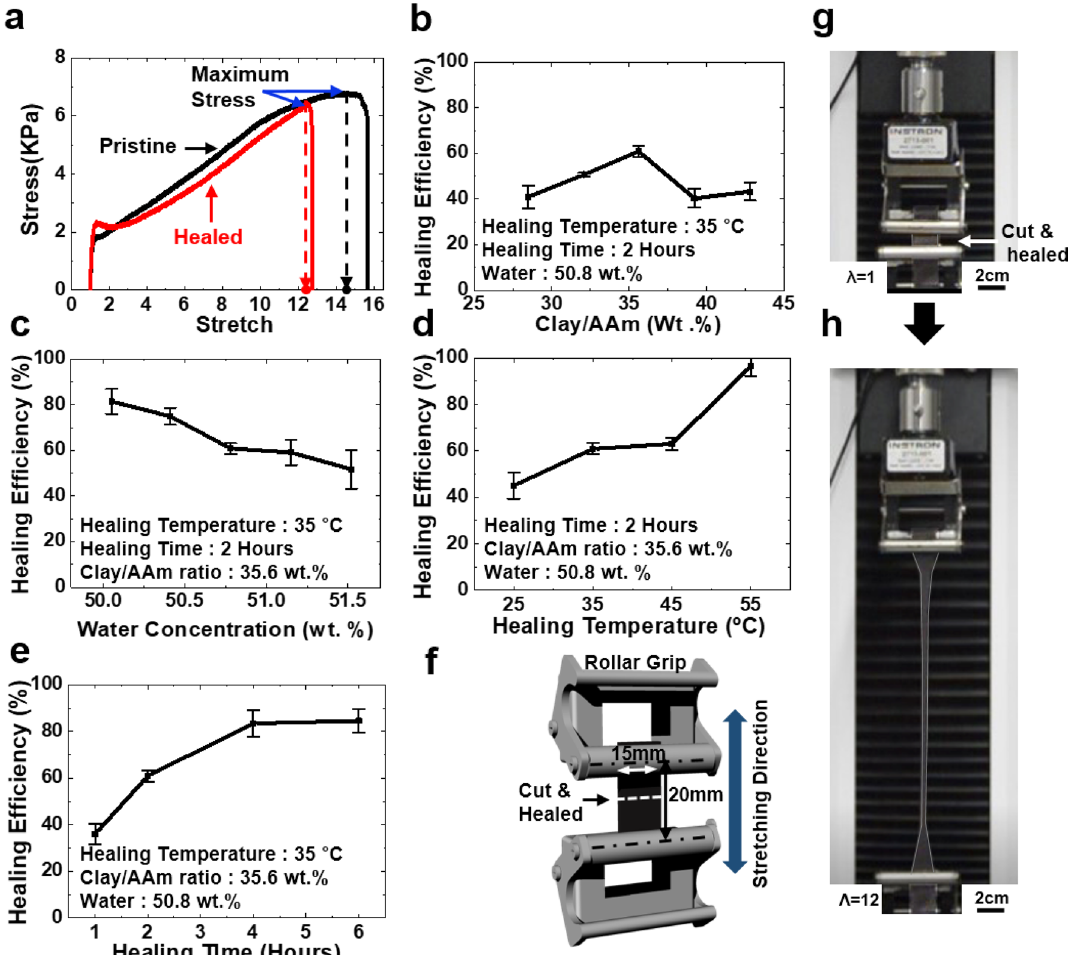
Figure 2. Self-healing performance of PAAm–Laponite–lead dioxide hydrogel. The molecular weight of lead dioxide is fixed as 3.23 M. ( a ) Tensile stress–strain curves of a pristine and a self-healing hydrogel containing 35.6 wt. % of Laponite versus PAAm. The sample was healed at 35 °C for 4 h. ( b – e ) The efficiency of self-healing in various conditions. Ratio between clay and PAAM, water weight percent, healing temperature and time were investigated. ( f ) Geometry of a grip and a sample for a tensile test. ( g , h ) Self-healing hydrogel is stretched up to 12 times of its initial length in a tensile machine. The gel has 35.6 wt% of clay/AAm ratio and 50.8 wt% of water content. The gel was healed at 35 °C for 4 h. Error bars show standard deviation; sample size n =